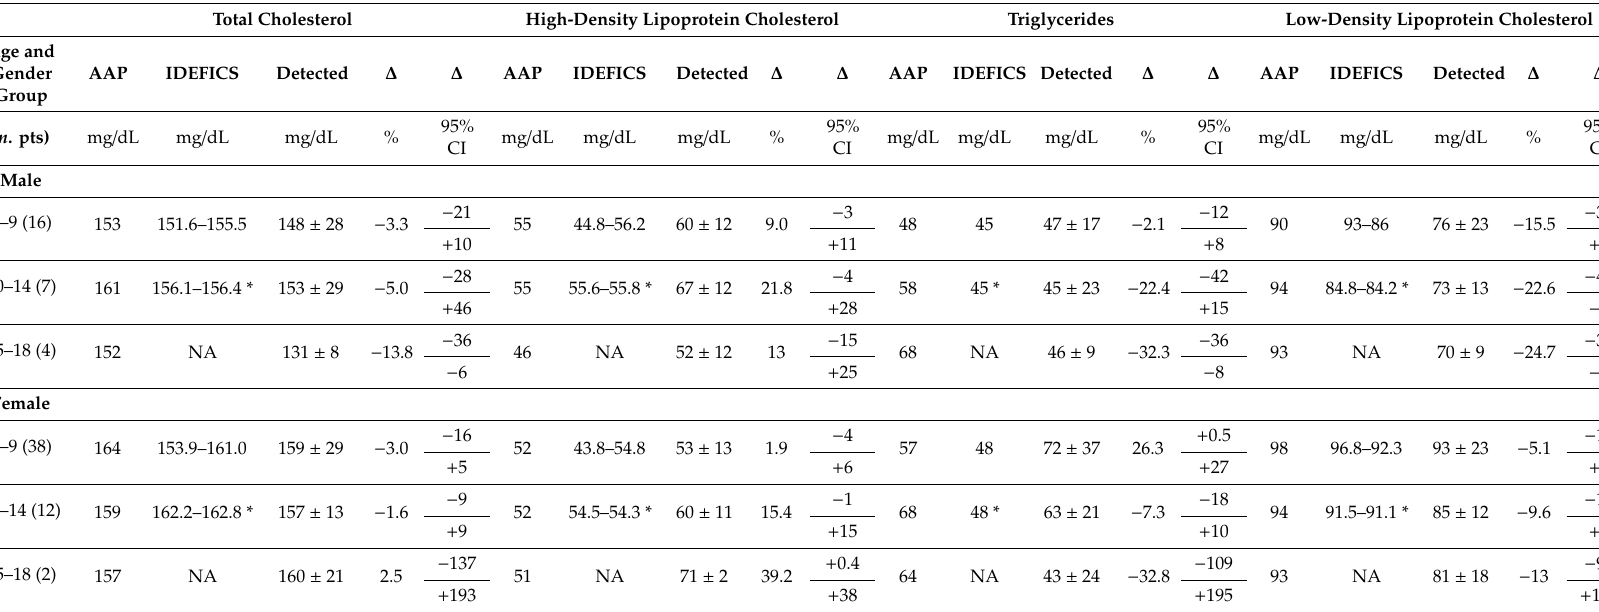
Table 2. Comparison between expected [22–24] and detected mean lipid profile values after the first year of gluten exclusion. Total Cholesterol High-Density Lipoprotein Cholesterol